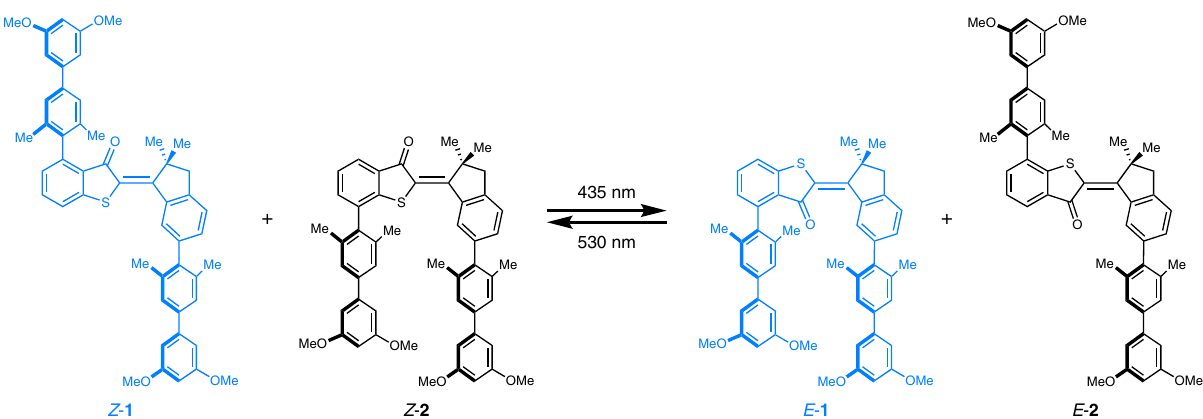
Fig. 1 Simultaneous complementary photoswitching of HTI tweezers. Two simultaneous processes are encountered at each wavelength of irradiation: at 435 nm tweezers 1 transform into their high af fi nity form ( E - 1 ) while tweezers 2 isomerize into their low af fi nity form ( E - 2 ). At 530 nm the processes are reversed and Z - 1 and Z - 2 are